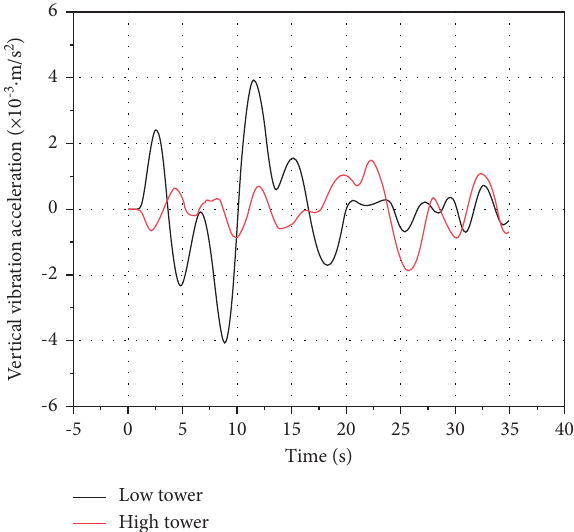
Figure 14: Comparison of vertical vibration acceleration time- history curves at L1 and R1.